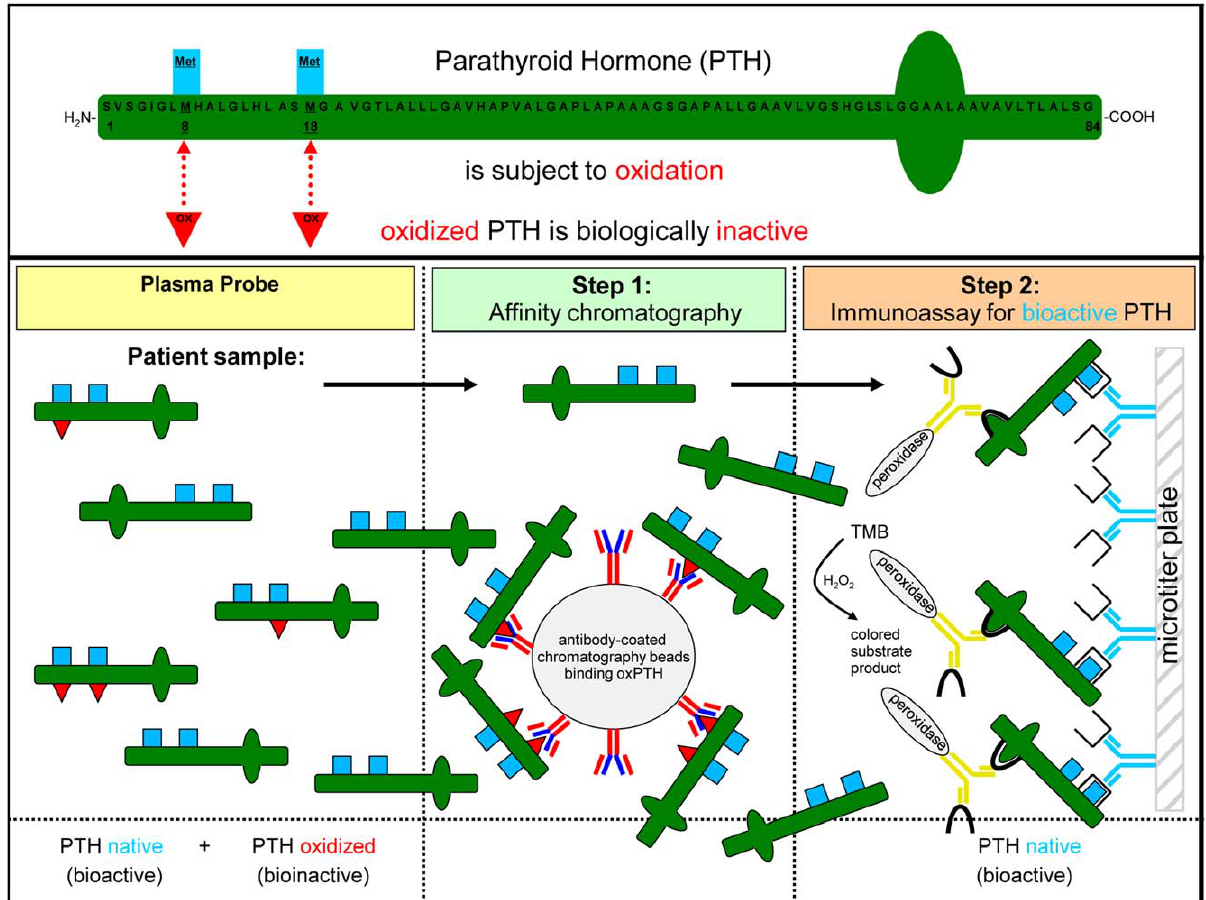
Figure 6. Basic principles of the new assay system for detection of intact and real intact PTH in human samples. The new detection process for real intact bioactive PTH consists of 2 steps: Firstly, any oxidized forms of oxidized PTH at position Met8 and/or position Met18 will be removed from the probe by a specific affinity chromatography column. The column contains monoclonal rat/mouse antibody (MAB) raised against the hPTH(1–34)oxidized fragments. These antibodies are able to remove any oxidized forms of PTH. In the second step the remaining non-oxidized PTH will be analyzed in conventional 2-site ‘‘sandwich’’ immunoassay systems. The antibody on the left ( capture antibody ) is bound to solid phase. The antibody on the right ( label antibody ) relays the signal. These antibodies must bind different sites on the PTH analyte to produce a positive result in the assay.